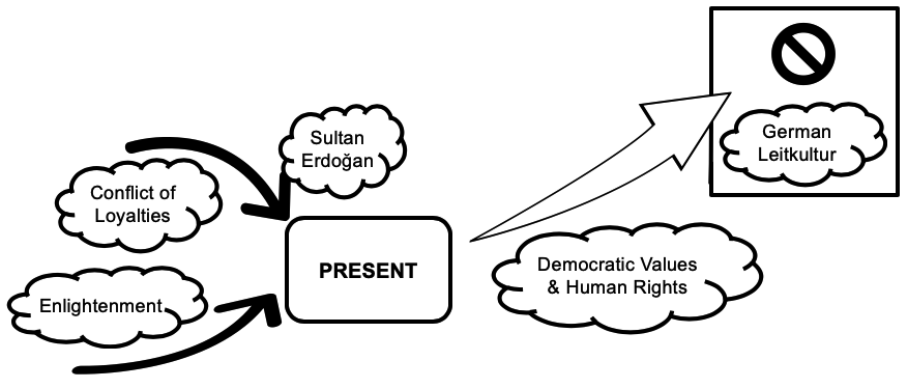
Figure 7. Comedy-romance story (cultural boundary) in Stage